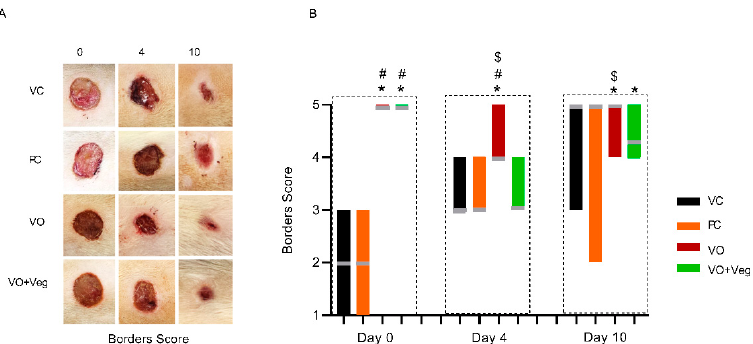
Figure 5. Representative photographs of borders in respective groups and treatment evaluation time ( A ). Graph of dryness scores in VC, PC, VO, and VO + Veg groups, in three periods of evaluation. The bars represent the data dispersion (minimum and maximum), and the horizontal gray lines represent mode ( B ). * p < 0.05: VO vs. VC; # p < 0.05: VO vs. PC, and $ p < 0.05: VO vs. VO + Veg.